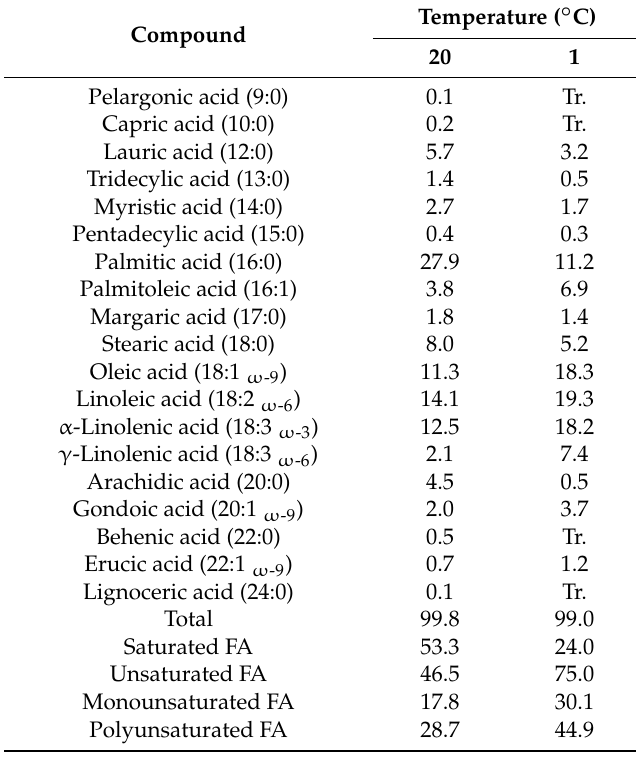
Table 2. Fatty acids (FA) composition of D. palmatum herb under different temperatures of cultivation (percentage of total FA content). Temperature ( ◦ Compound